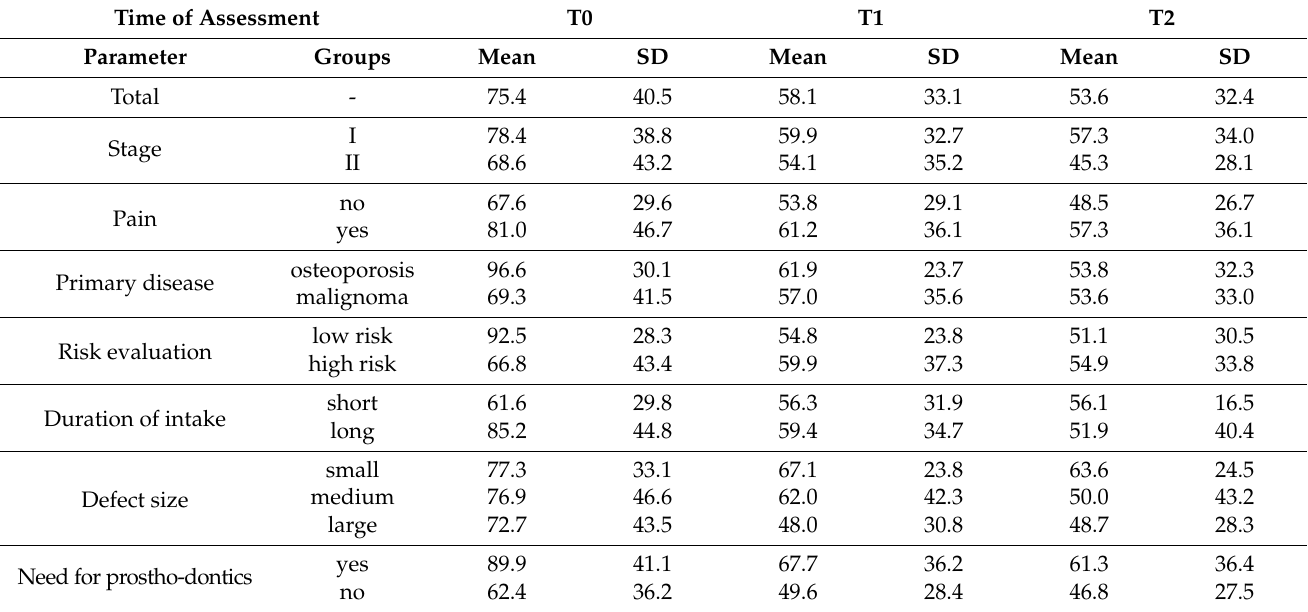
Table 3. OHIP scores for all parameters investigated and times of assessment (T0/T1/T2). SD: standard